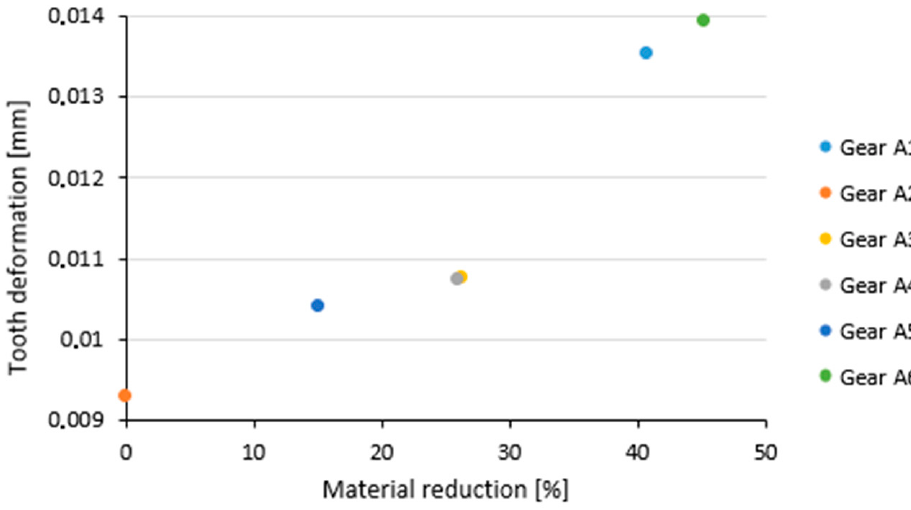
Figure 9. Influence of rim thickness on gear stiffness. A comparison of the effect of material reduction on gear deformation is shown in Figure 10. The greater the mass reduction, then the greater the final gear deformation. By comparing the effect of the percentage reduction in mass on the deformation of the gearing, the forged wheels marked A3 and A4 appear to be the most suitable variants (Table 2). These wheels have very similar gear deformations and mass reductions, while they differ in shape from each other. The A4 variant appears to be more advantageous from the point of view of the economy than the A3 variant, which has a more complicated shape for production and requires an additional machining process by drilling relief holes.